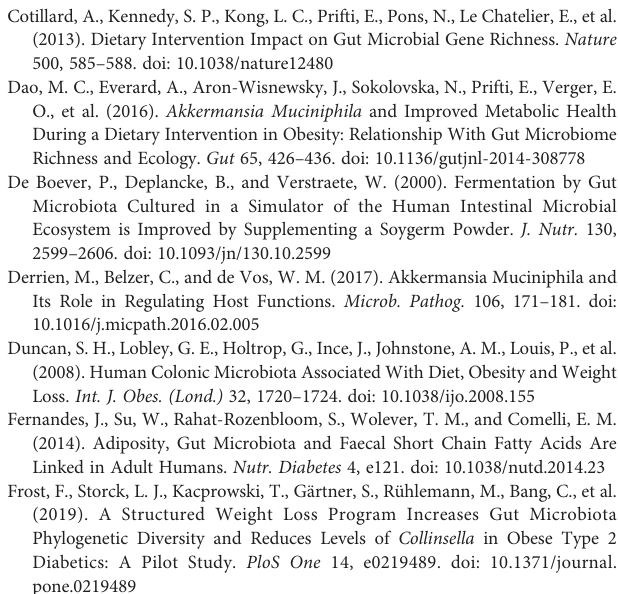
Supplementary Figure 1 | Projection of the variables genera taxa, SCFAs and ammonium on the factor-plane de fi ned by the two principal components PC1 and